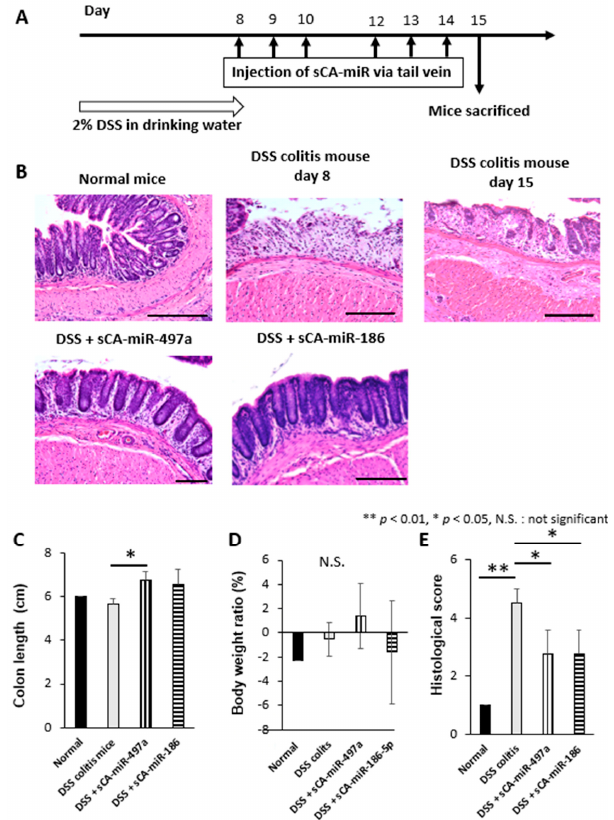
Figure 8. Comparative study on the therapeutic efficacy between sCA-miR-497a-5p and sCA-miR- 186-5p. ( A ) The treatment schedule of induction of colitis by DSS and injection of drugs. 2.0% DSS was administered in drinking water for 8 days. sCA loaded with miRNA (50 µg) was injected on